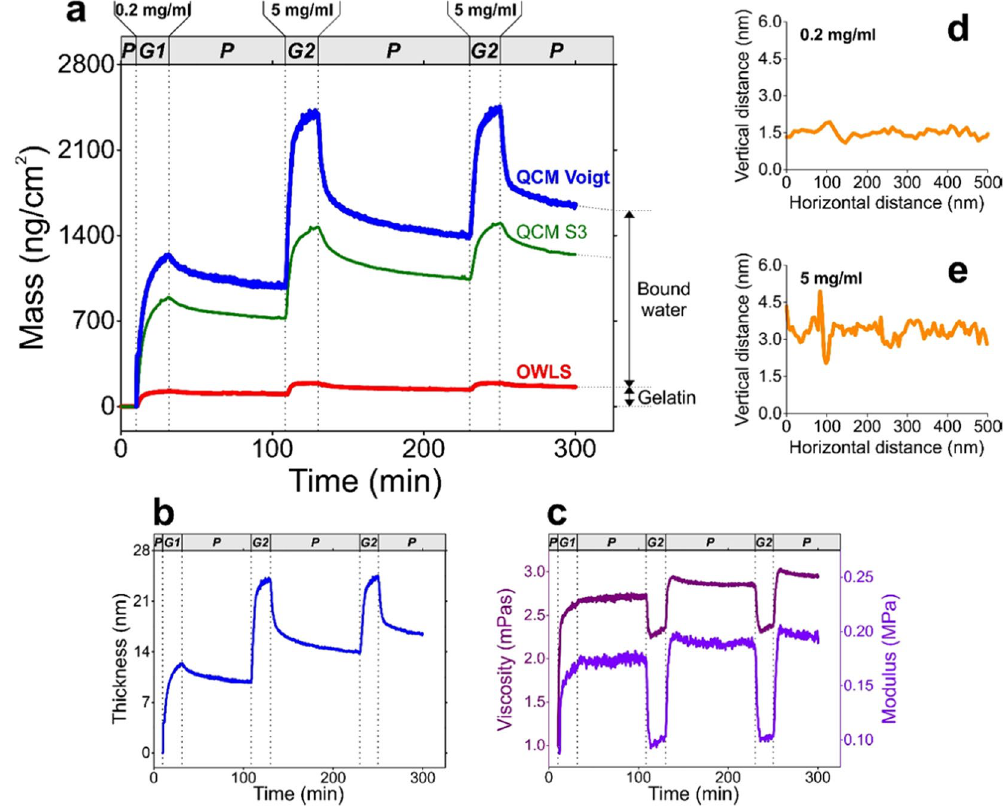
Figure 3. Results obtained from the combined evaluation of QCM-I and OWLS measurement data, supplemented by AFM measurements. ( a ) Areal mass density of the formed gelatin layer, resulting from QCM-I and OWLS measurements. The graph header and dashed vertical lines indicate the phases of the experiment (P: PBS flow, G1: flow of 0.2 mg/ml gelatin solution, G2: flow of 2 mg/ml gelatin solution). While the mass curve derived from the OWLS measurement (red line) represents the mass of the gelatin chains itself (“dry” mass), the mass data obtained from QCM-I represent the mass of the hydrated gelatin layer (“wet” mass). Two types of hydrated mass data were calculated: one relying on the Sauerbrey equation (thin green line, calculated from the 3 rd overtone frequency shift data) as well as the other one resulting from the fit of the Voigt-based viscoelastic model (thick blue line). The difference between the “wet” and “dry” masses indicates the amount of bound water. ( b,c ) Thickness ( b ) and viscoelastic properties ( c ) of the formed gelatin layer (shear viscosity (purple line) and shear elastic modulus (red line)), calculated by fitting the Voigt-model. The experimental phases are indicated as above in graph ( a ). The thickness is proportional to the mass data of graph ( a ) with the factor of layer viscosity, estimated to be 1000 kg/m 3 . ( d,e ) AFM line scans of gelatin surfaces prepared from 0.2 mg/ml ( d ) and 5 mg/ml ( e ) gelatin